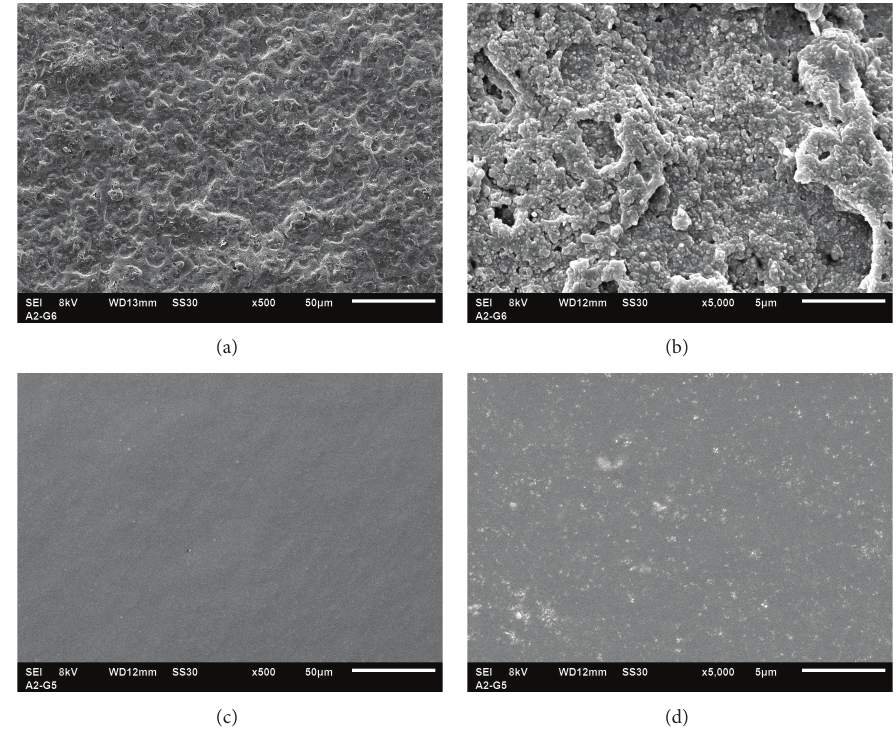
Figure 3: Photomicrographs of surfaces morphologies of the sealers analyzed by using scanning electron microscopy. MTA FillApex magnification of 500x (a) and 5000x (b). AH Plus magnification of 500x (c) and 5000x